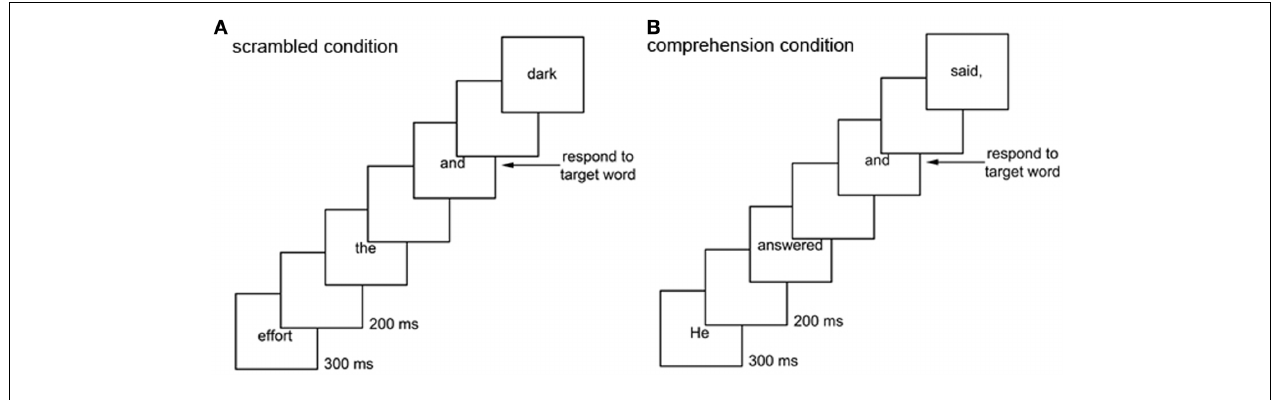
FIGURE 1 | Scrambled and comprehension conditions. In the scrambled condition (A) , a story was presented in a scrambled order one word every 500ms, and participants were asked to perform the target-word detection task: pressing a mouse button every time they saw the word “and.” In the comprehension